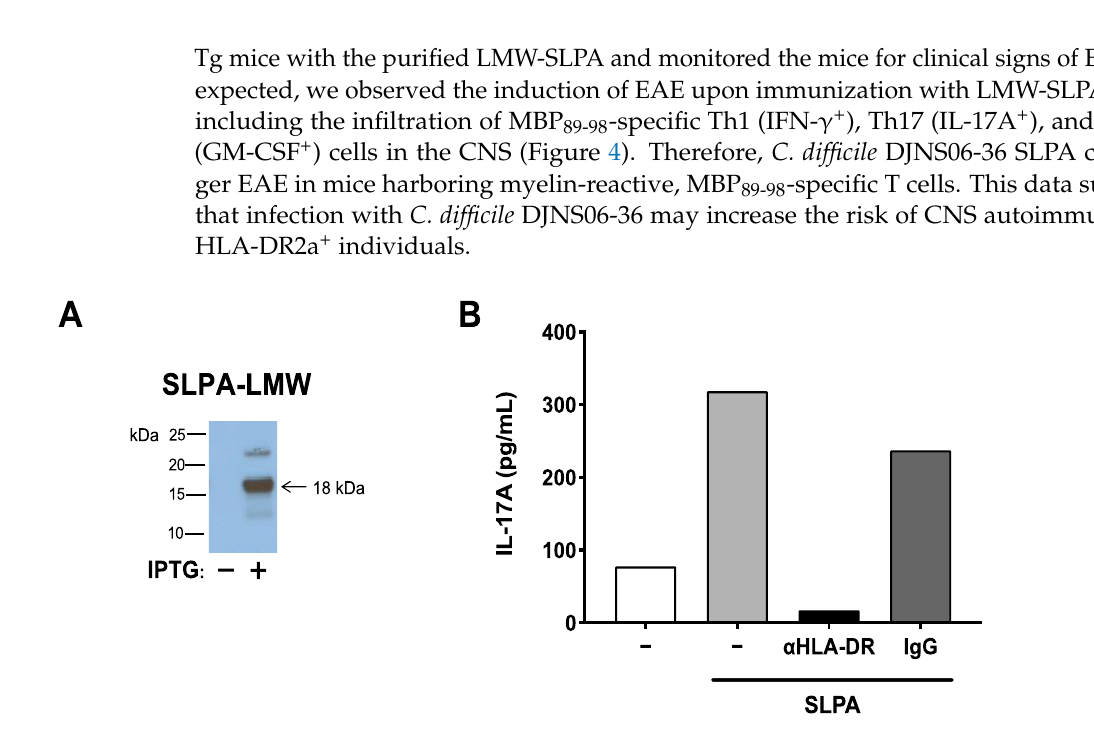
Figure 3. SLPA produced by C. difficile DJNS06-36 can be processed and presented to DR2a-restricted MBP 89-98 -specific T cells. ( A ) Purification of LMW-SLPA from BL21 Star™ (DE3) E. coli that expresses LMW-SLPA DNA isolated from C. difficile DJNS06-36. His(6X)-tagged LMW-SLPA protein was induced by IPTG. ( B ) Memory T cells isolated from MBP-TCR/DR2a Tg mice were cultured with the purified LMW-SLPA in the presence of anti-HLA-DR mAb or isotype control IgG. IL-17A production in response to LMW-SLPA in the context of DR2a was examined. Data from one representative experiment of two independent experiments is presented.